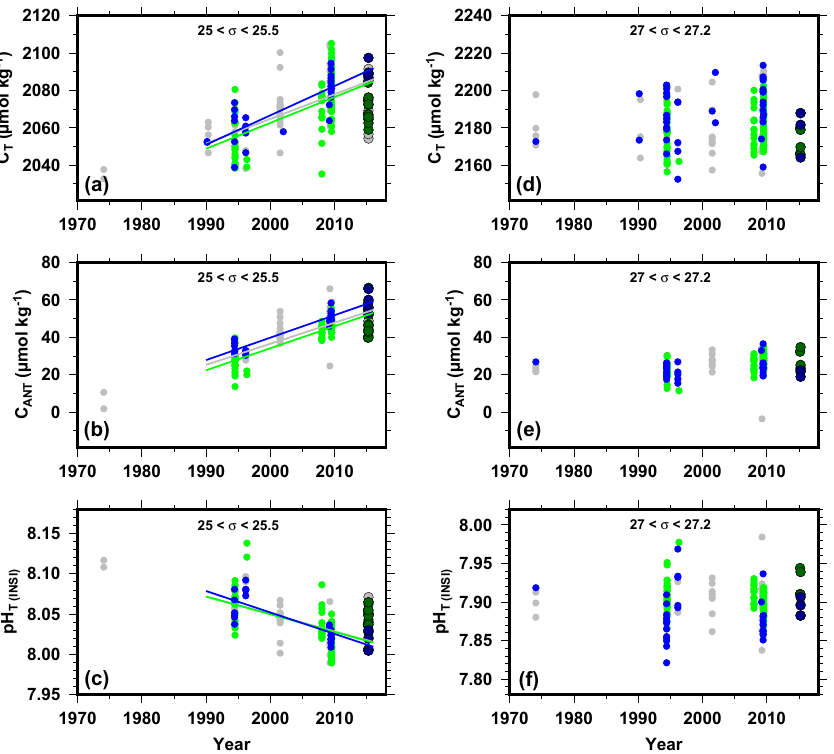
Figure 5. Temporal evolution in the OUTPACE area of C T (a, d) , C ANT (b, e) and pH Tinsi (c, f) based on GLODAPv2 and OUTPACE data along two isopycnal layers: 25–25.5kgm − 3 (a, b, c) and 27–27.2kgm − 3 (d, e, f) . The color code for the dots is the same as for Fig.